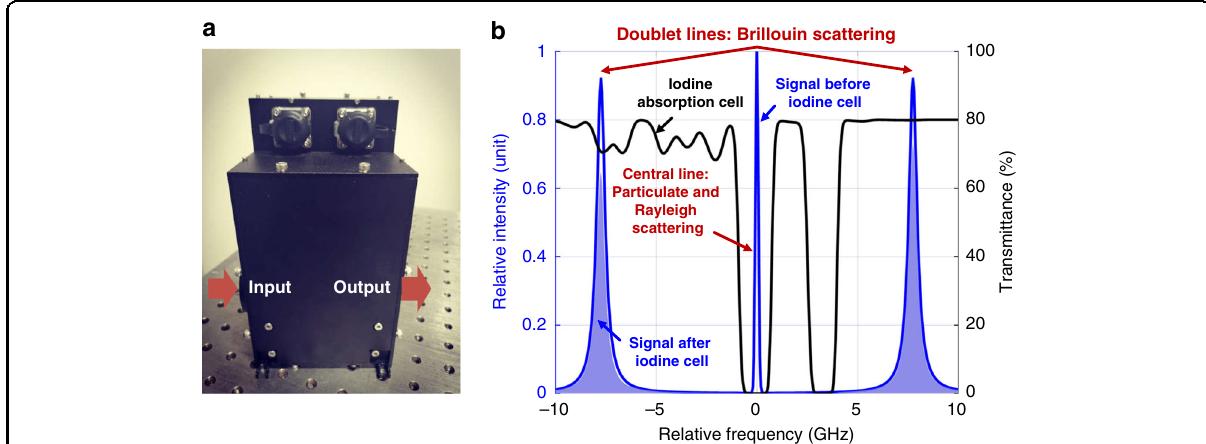
Fig. 6 The ultra-narrow discrimination of the iodine cell. a The picture of the packed iodine absorption cell integrated with the temperature controller. The light enters the device from the left and leaves from the right. b Illustration of the spectral discrimination, where the iodine cell (black line) fi lters the signal (blue line) by rejecting the particulate and molecular Rayleigh signals and transmitting molecular Brillouin signal (blue